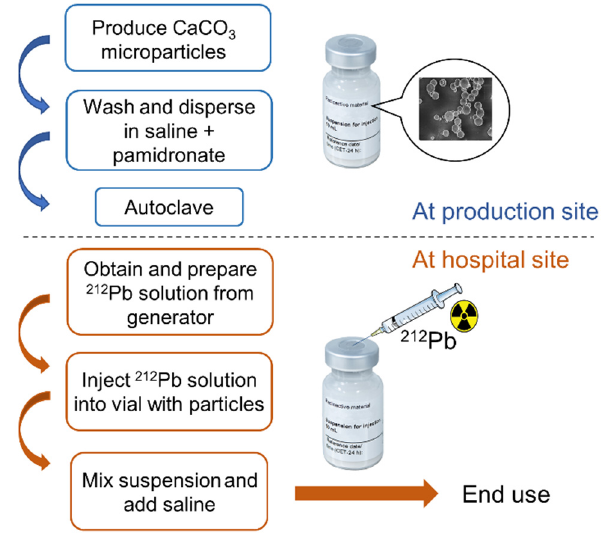
Figure 2. Scheme of the production process of 212 Pb-labeled CaCO 3 microparticles, showing the steps that can be performed on-site by the end user.